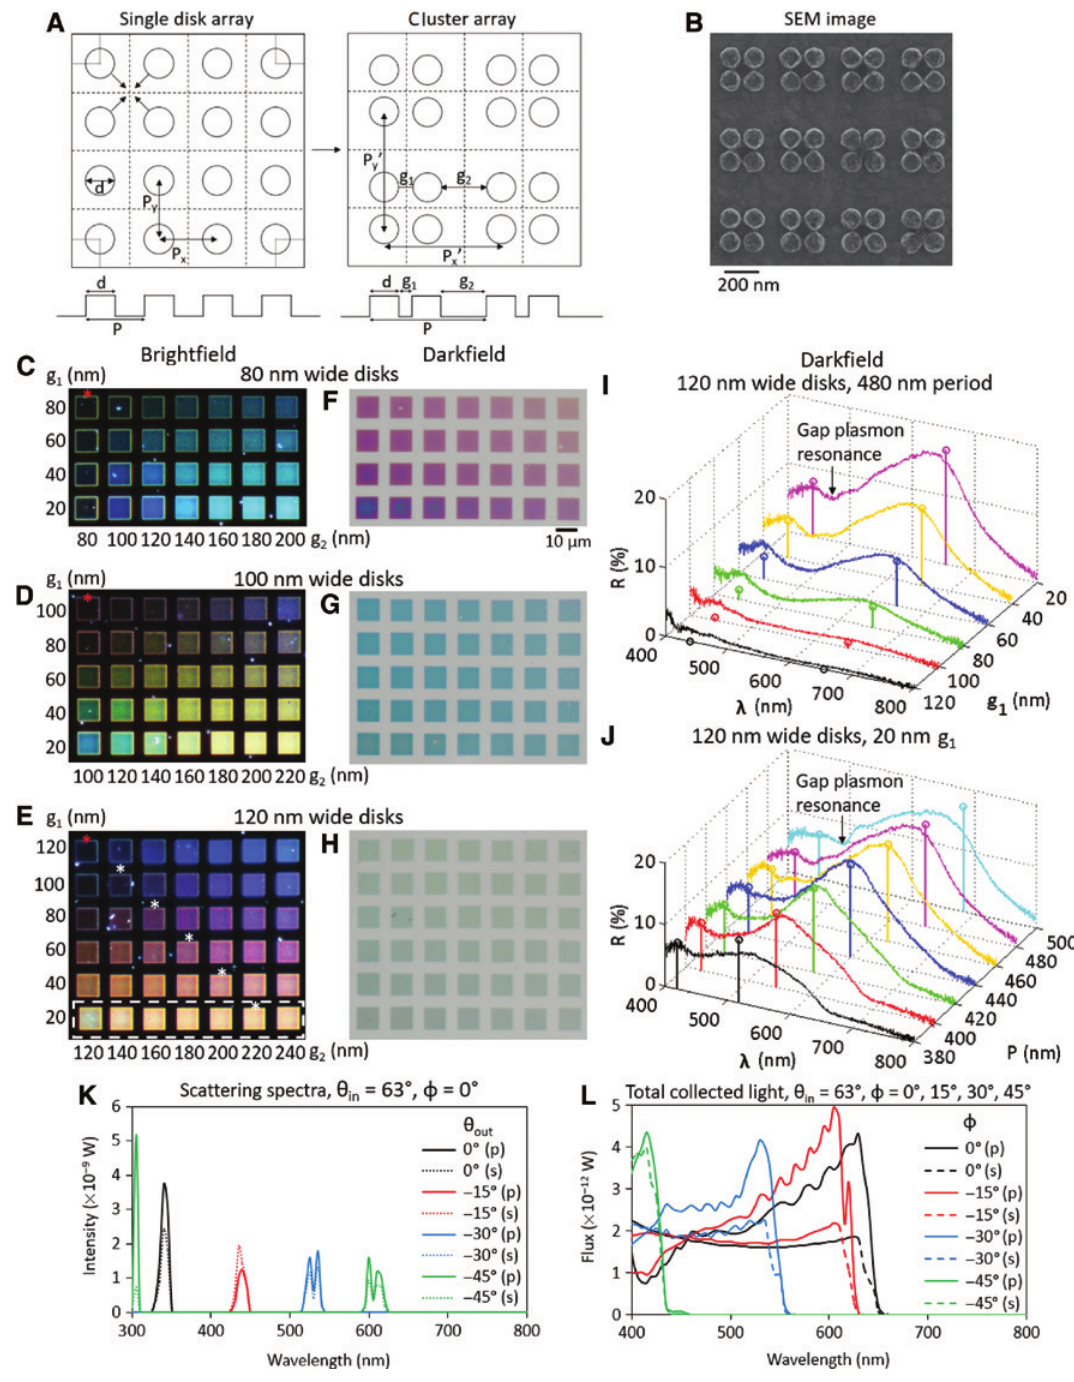
Figure 4: Darkfield colors from disk clusters. (A) Schematic of array of single-disk and disk cluster arrays. The diameter d , period P ′ , inter-disk gap g , and inter-cluster gap g are 1 2 = 20 nm, and g = 120 nm. Darkfield micrographs of (C) 80 nm wide disk clusters indicated. (B) SEM image of disk clusters with d = 120 nm, g 1 2 with g from 20 nm to 80 nm and g from 80 nm to 200 nm, (D) 100 nm wide disk clusters with g from 20 nm to 100 nm and g from 100 nm 1 2 1 2 to 220 nm, and (E) 120 nm wide disk clusters with g from 20 nm to 120 nm and g from 120 nm to 240 nm. Brightfield micrographs of (F) 1 2 80 nm wide disk clusters, (G) 100 nm wide disk clusters and (H) 120 nm wide disk clusters. (I) Darkfield reflectance spectra for 120 nm wide disks and 480 nm period, with g from 20 nm to 120 nm. (J) Darkfield spectra for 120 nm wide disks and g of 20 nm, with a period from 1 1 380 nm to 500 nm. The normalized Fourier coefficients are also shown as open circles connected by vertical lines. (K) Scattered field spectra for array of 120 nm wide disk clusters with g of 20 nm and a period of 380 nm, under p - and s -polarized illumination from polar angle of 63 ° 1 and azimuthal angle of 0 ° . (L) Total collected light for disk cluster array under p - and s -polarized illumination from polar angle of 63 ° and azimuthal angles of 0 ° , 15 ° , 30 ° , and 45 °